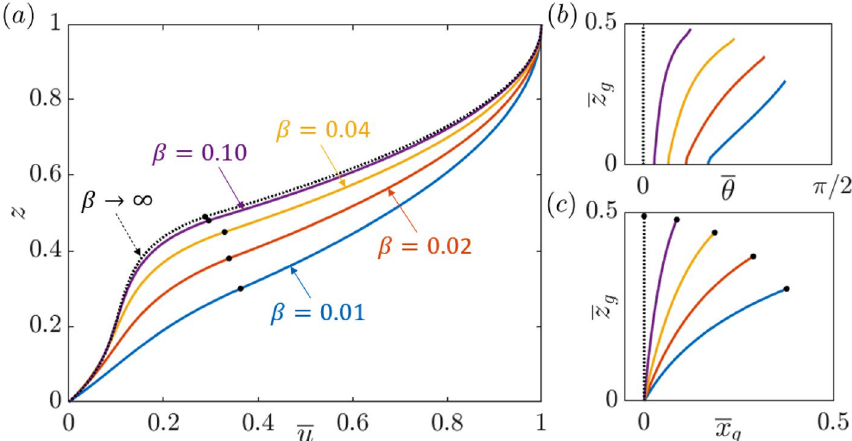
Figure 2. Steady-state ( a ) horizontal velocity profile u ( z ) , and the corresponding ( b ) angle with the vertical θ( z ) and ( c ) blade shape ( x g , z g ) , for Re = 1000 , r = 0.5 , (cid:31) = 1 , and Fr 2 = 0.1 . Buoyant grass model, with no-slip velocity boundary condition at z = 0 , and β = 0.01 , 0.02, 0.04, 0.10, and ∞ (dotted). The black markers on ( a ) and ( c ) mark the vertical position of the corresponding canopy tip h g in each